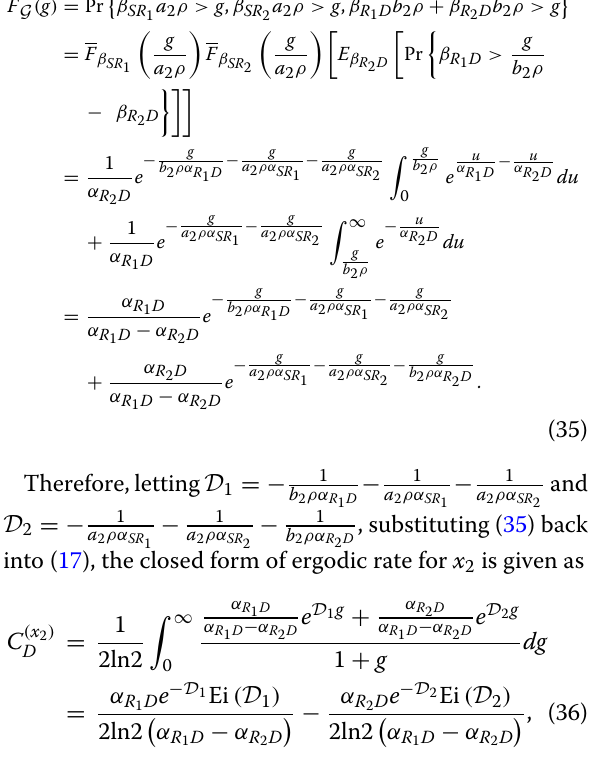
= α = 10, α = 2, and α = { 10,40 } versus the transmission SR 2 R 1 D R 2 D 1